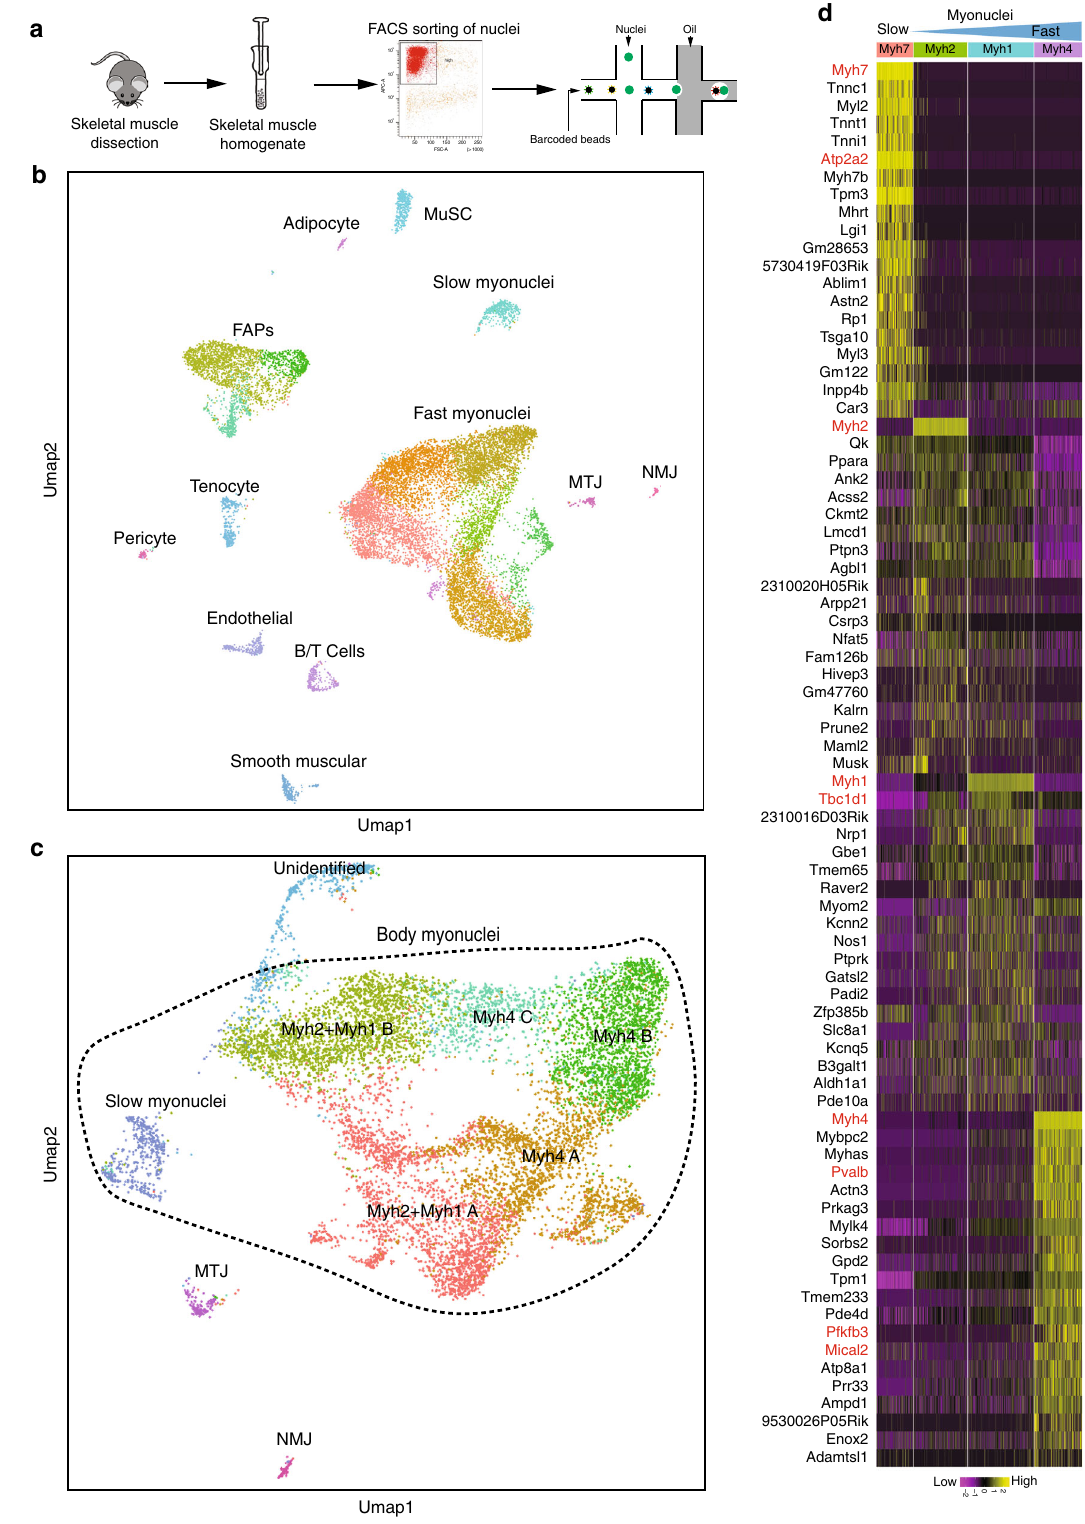
Fig. 1 SnRNA-seq analysis from adult slow and fast skeletal muscles. a Graphical scheme of the experiments used for snRNA-seq analysis of adult skeletal muscles. b Uniform Manifold Approximation and Projection (Umap) diagram from snRNA-seq from adult skeletal muscle. MuSC skeletal muscle stem cells, FAPs fi bro-adipogenic progenitors, MTJ myotendinous junction, NMJ neuromuscular junction. c Umap diagram of snRNA-seq data with myonuclei only. Myonuclei are separated into fi ve clusters: slow, fast, MTJ, NMJ, and unidenti fi ed myonuclei. The slow and fast myonuclei are called body nuclei and are surrounded by dotted lines. Five subcategories of fast myonuclei are clustered. d Heatmap of genes upregulated (yellow) and downregulated (violet) in the myonuclei expressing the different slow and fast Myh isoforms. The values correspond to z -scores of normalized